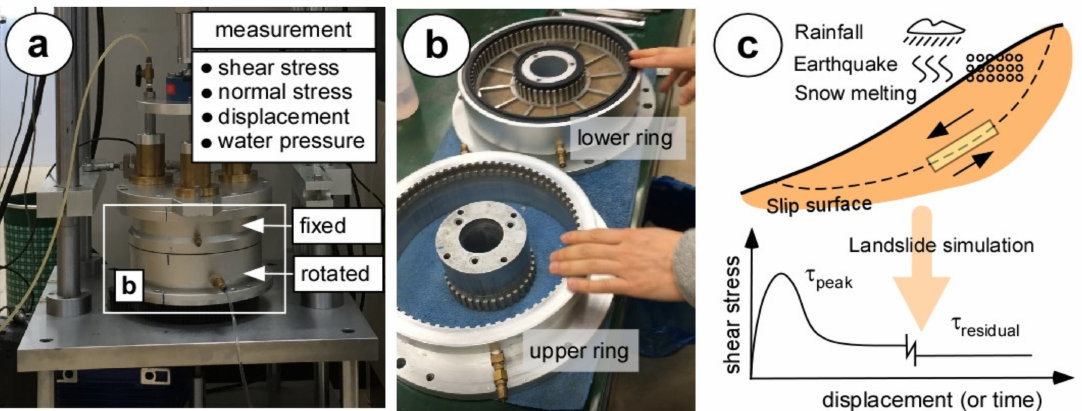
Figure 1. Ring shear apparatus: ring shear box with rough surfaces for minimizing slippage and a schematic illustration of the development of shear stress at the landslide